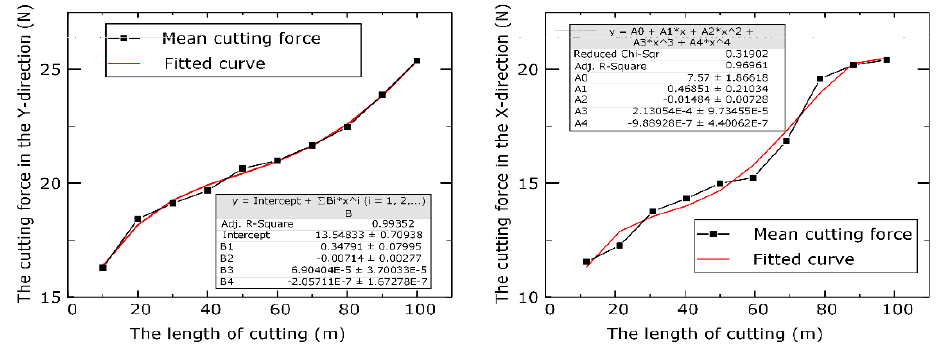
Figure 2. the milling force in the Y and X ‐ direction. Figure 2. The milling force in the Y and